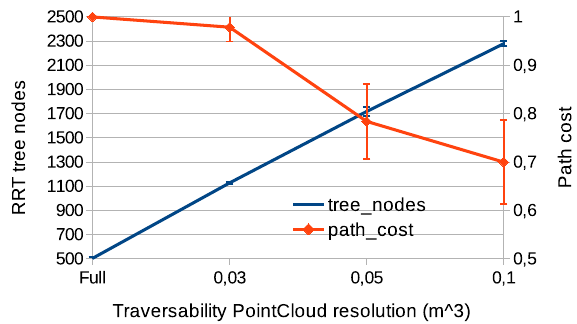
Figure 7. Comparison of pointcloud resolution for traversability versus size of RRT ∗ tree and path costs in 5 secs of planning in the tunnel